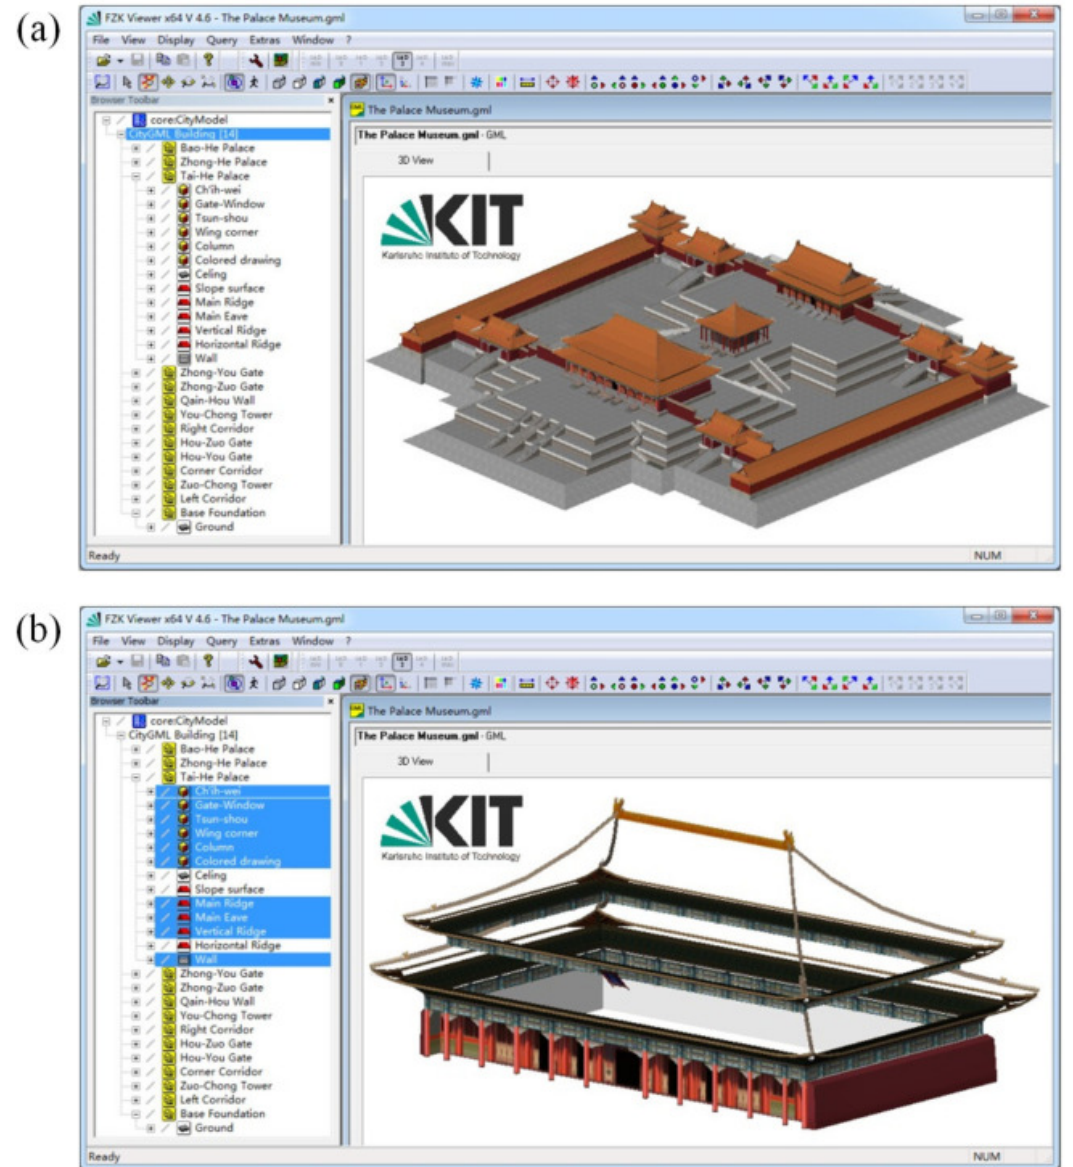
Figure 9. Experimental results. ( a ) An overview of the principal buildings of the Palace Museum; ( b ) the Tai-He Palace model without slope surfaces.